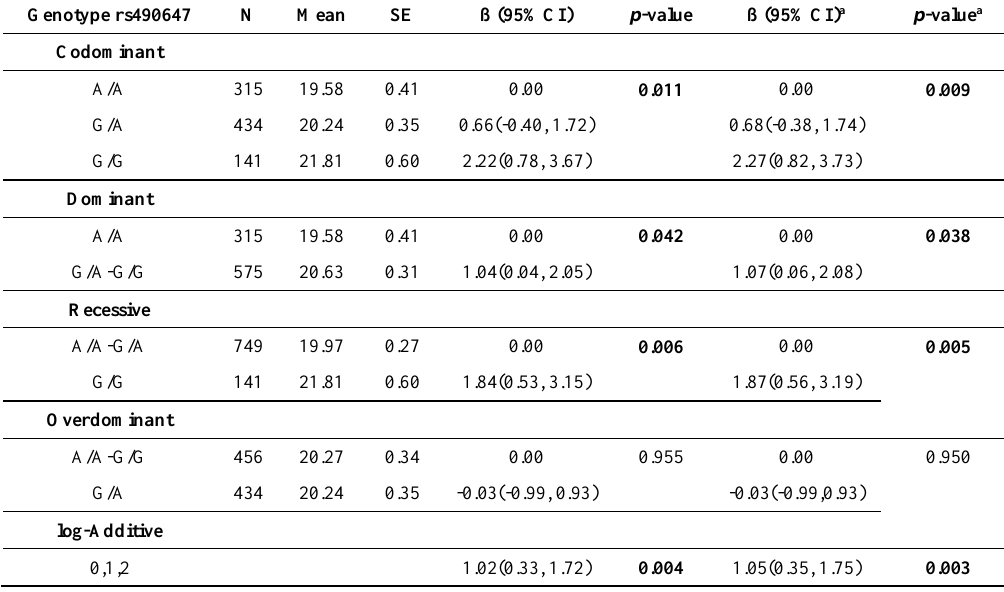
Table 5. Association between rs490647 and subjective well-being in five genotype